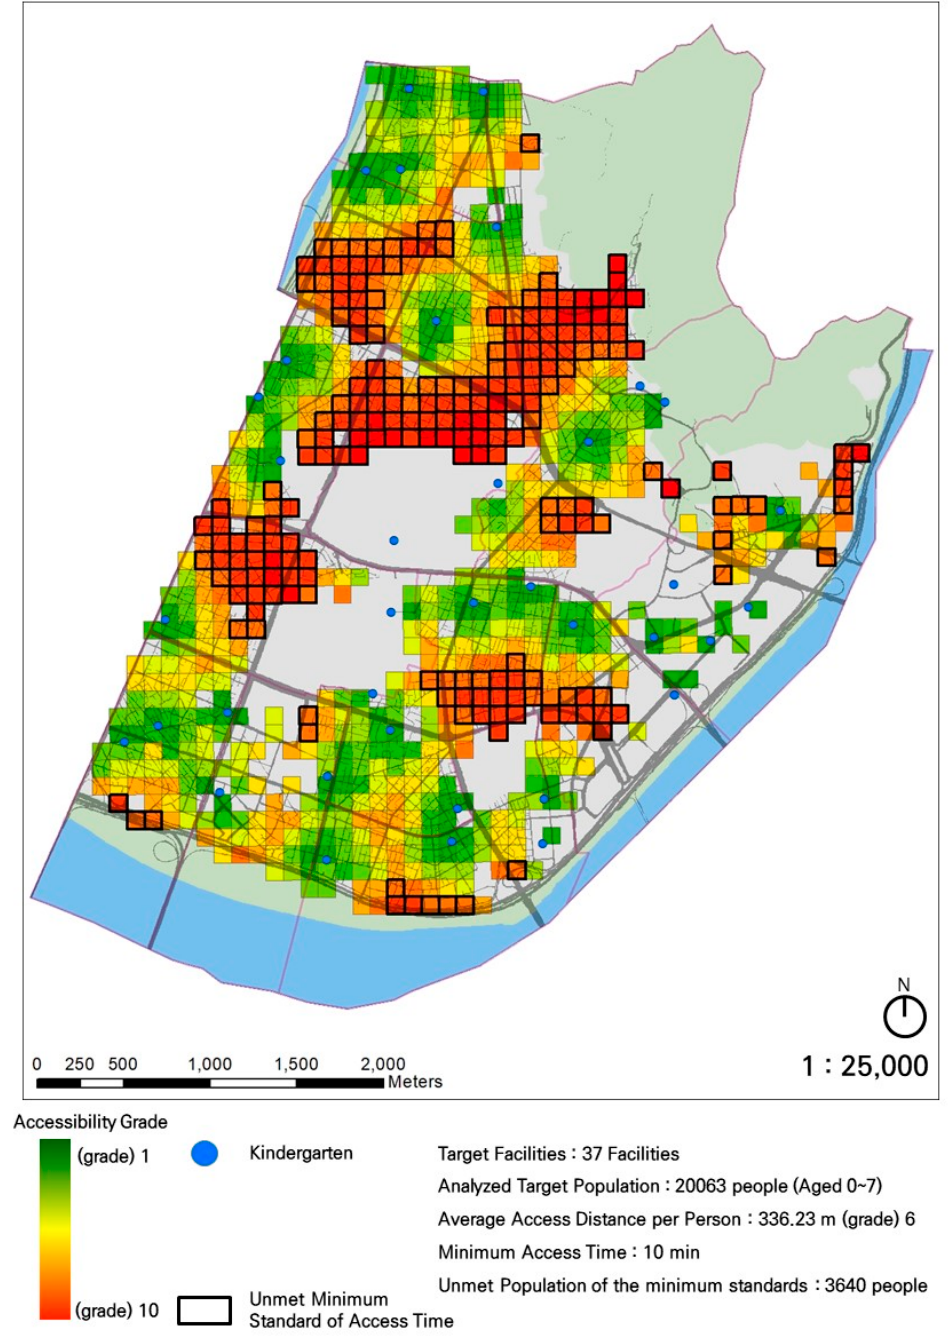
Figure 2. 100 × 100 Analysis (Educational SOC) through the population grid.